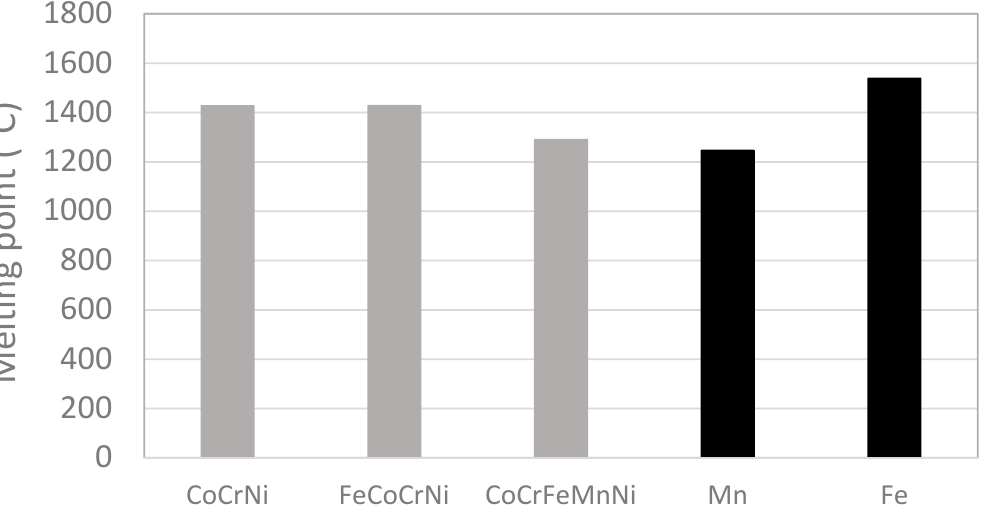
Figure 2. The effect of Mn and Fe on the melting point of the CoCrNi-based alloys. The melting point of Mn and Fe (black columns) was plotted for a comparison with the produced alloys (grey columns).